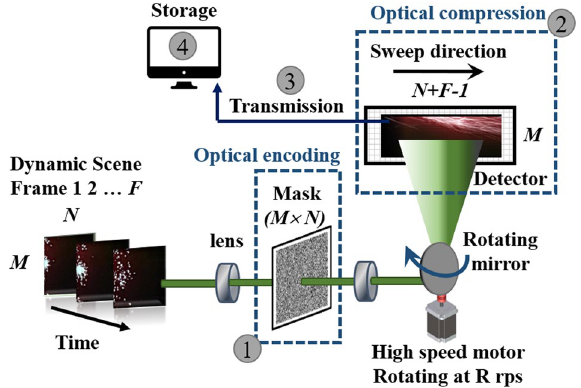
Figure 1. Configuration and operation principle of the proposed CCRM camera